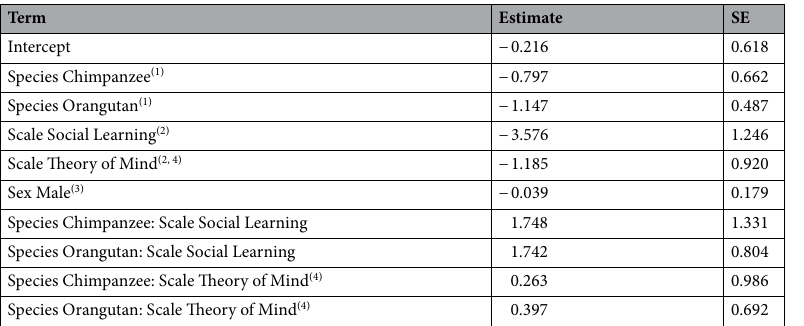
Table 4 Species comparison for behaviours with unknown chance probability. Table 4 depicts species comparison for behaviours with unknown chance probability. (1) Dummy coded, the reference category was Raven. (2) Dummy coded, the reference category was scale Communication only including the task Attentional State. (3) Dummy coded with female being the reference category. (4) Only including the task Gaze